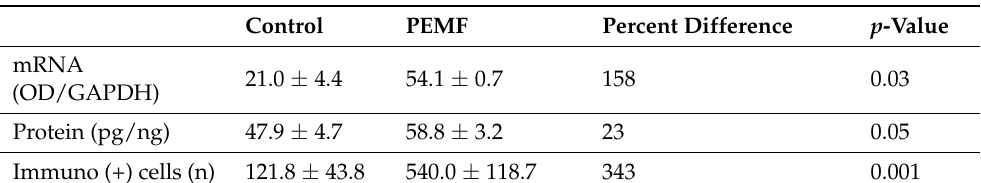
Table 3. Quantitative increases in TGF- β synthesis with PEMFs. On day 6 of development, during the peak TGF- β production, the increase produced by PEMF stimulation was 0.08 pg/pg DNA. Overall, PEMF exposure produced significant increases in TGF- β protein, mRNA, and immunopositive cells compared to unexposed control ossicles. Adapted with permission from Ref. [10]. 2002, Journal of Orthopaedic Research .